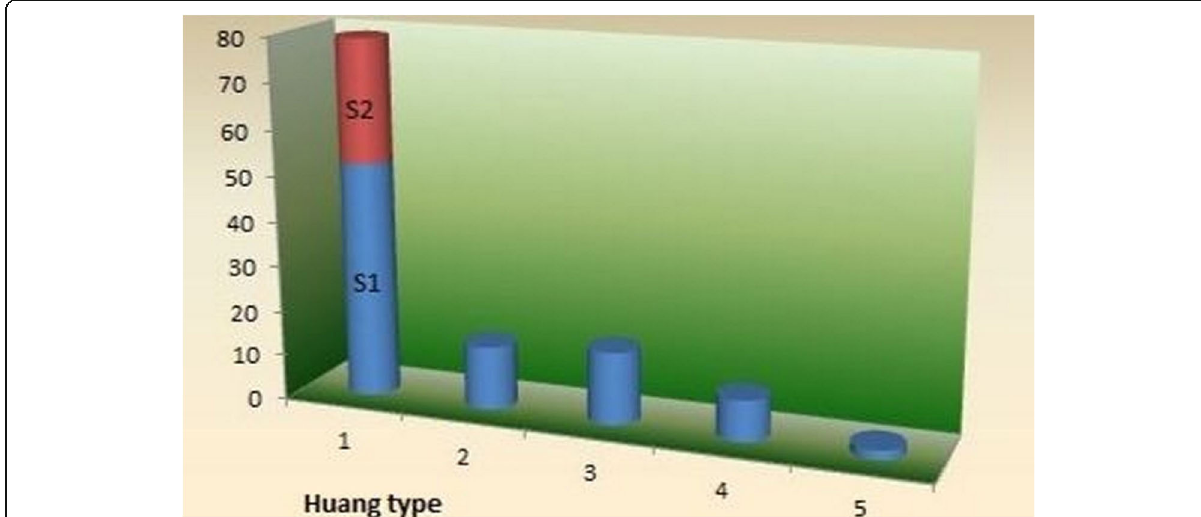
Fig. 2 Prevalence of biliary variants (Huang types) among study